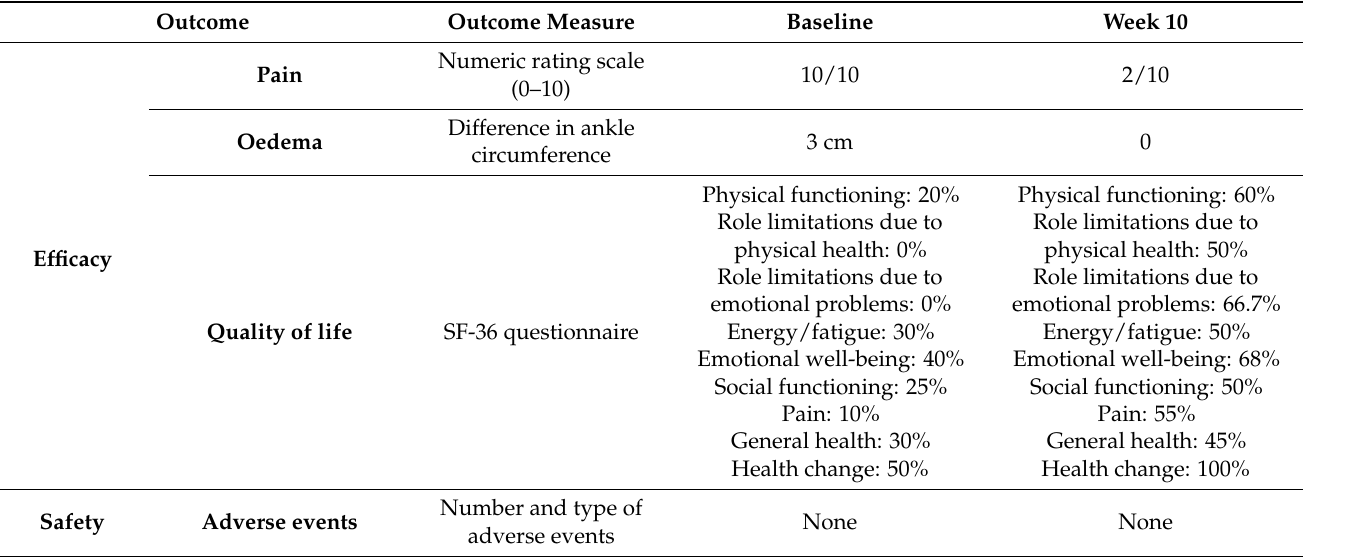
Table 2. Summary of the